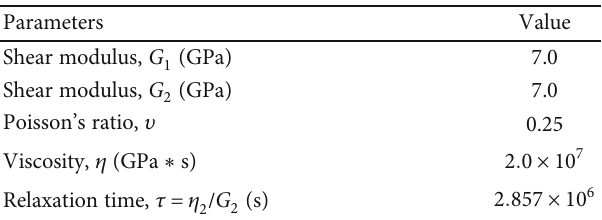
Table 6: Input parameters for the SLS model (see Section 3 for the model